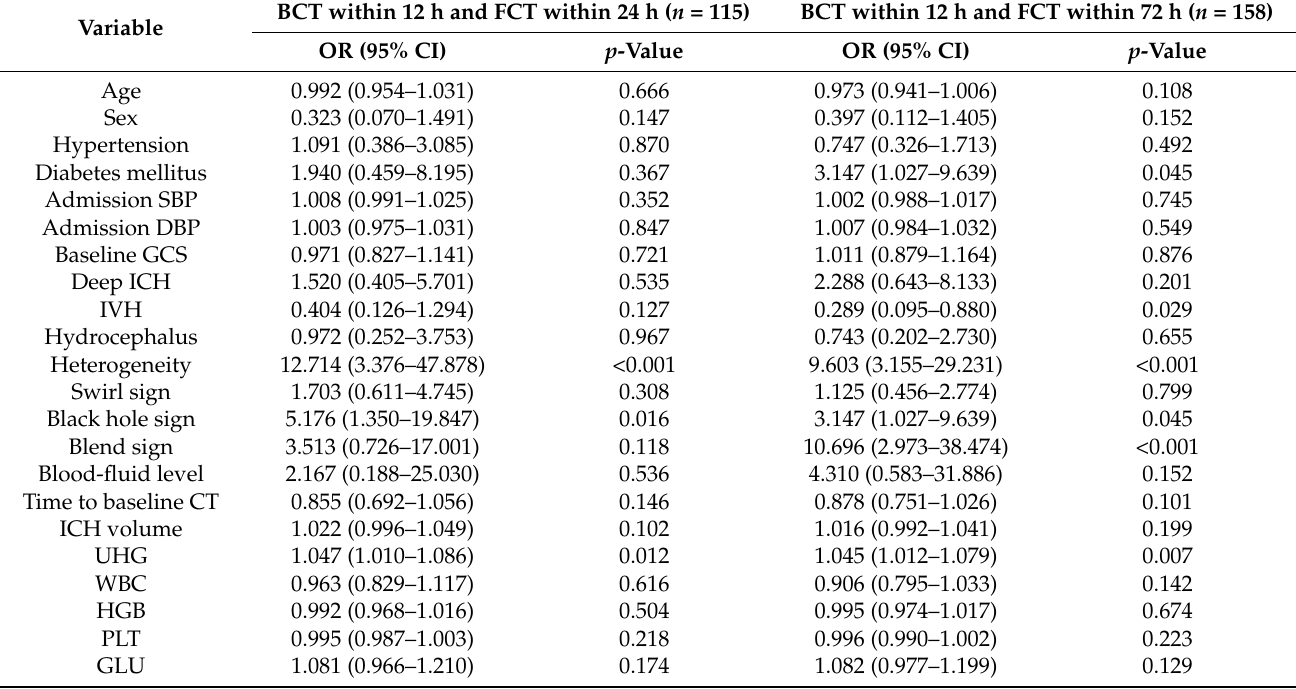
Table 6. Univariate analysis of the predictors of hematoma expansion for a time to baseline CT within 12 h.